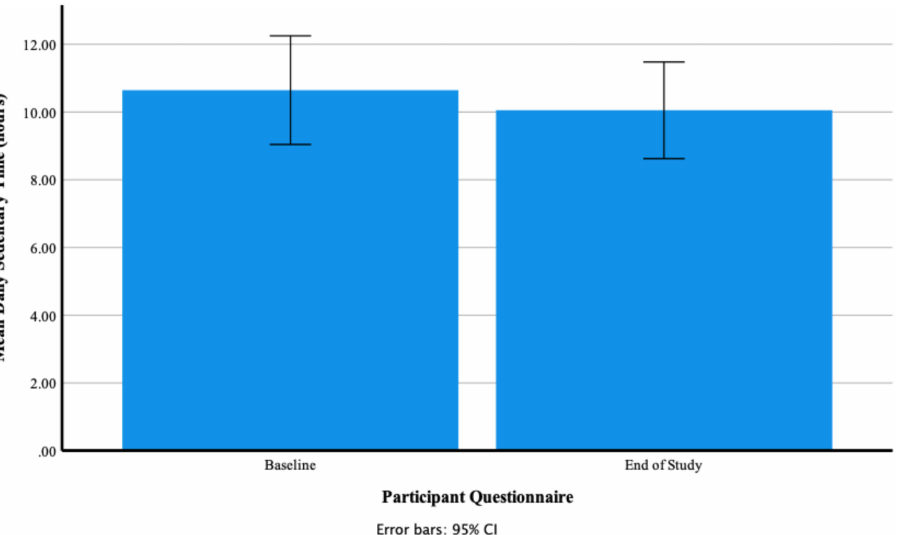
Figure 12. Participants’ self-reported mean daily hours of sedentary time at baseline and end of study.